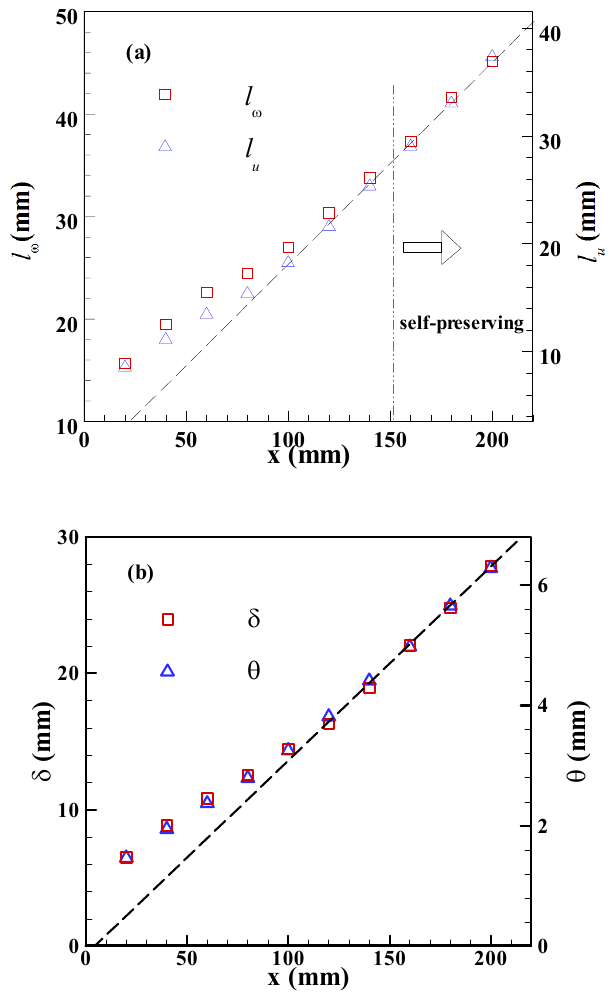
Figure 8 Evolution of (a) l